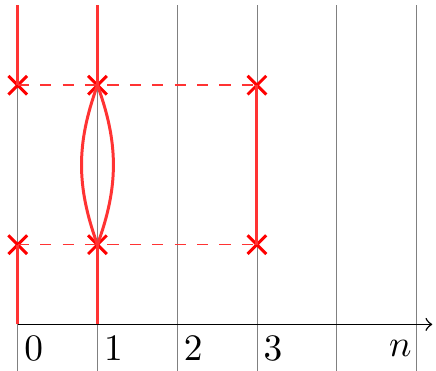
Figure 36. An example Feynman diagram arising at second order in φ 3 perturbation theory. This diagram involves | 0 , 1 i resp. h 0 , 1 | as in- and out-states and | 1 , 1 , 3 i as an intermediate